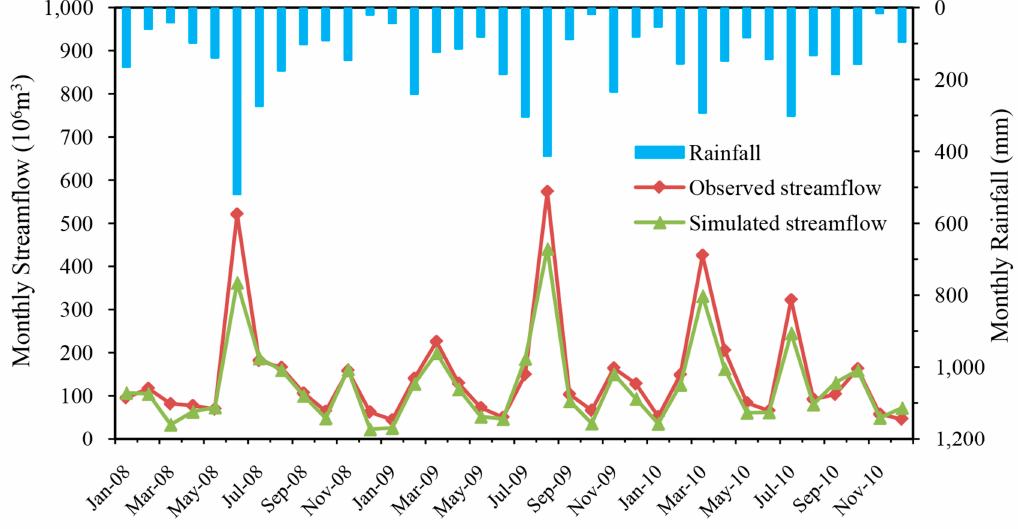
Figure 4. Comparison between simulated and observed monthly streamflow in the Xitiaoxi watershed during the validation period (January 2008 to December 2010).